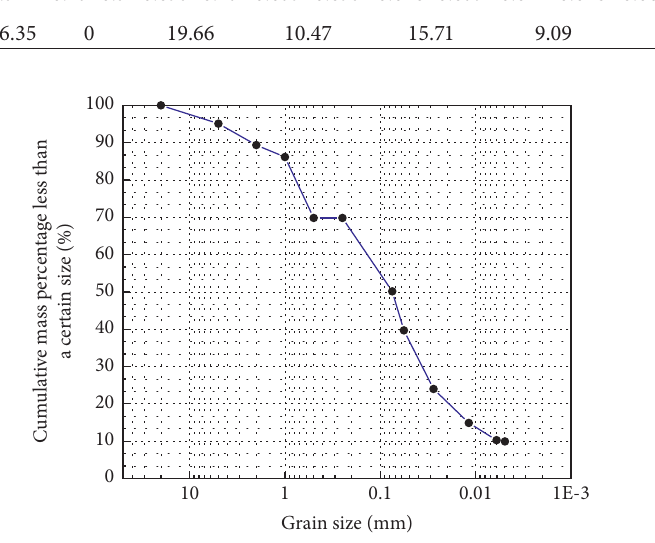
Figure 3: Grain size distribution of the soil sample. Table 4: Mineral composition percentage of soil samples from different locations